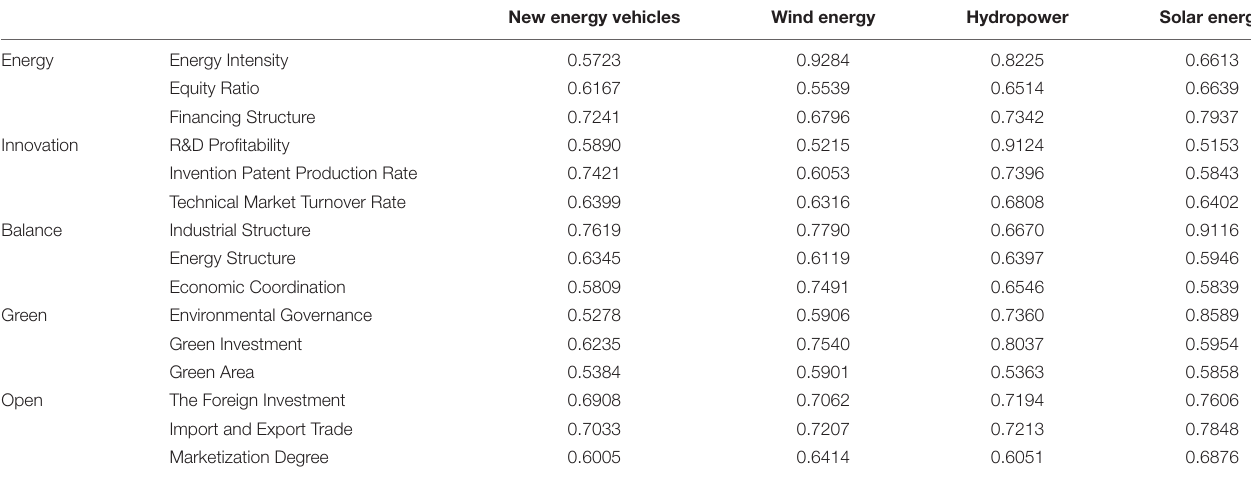
TABLE 5 | Comprehensive correlation degree of high quality indicators of energy finance.